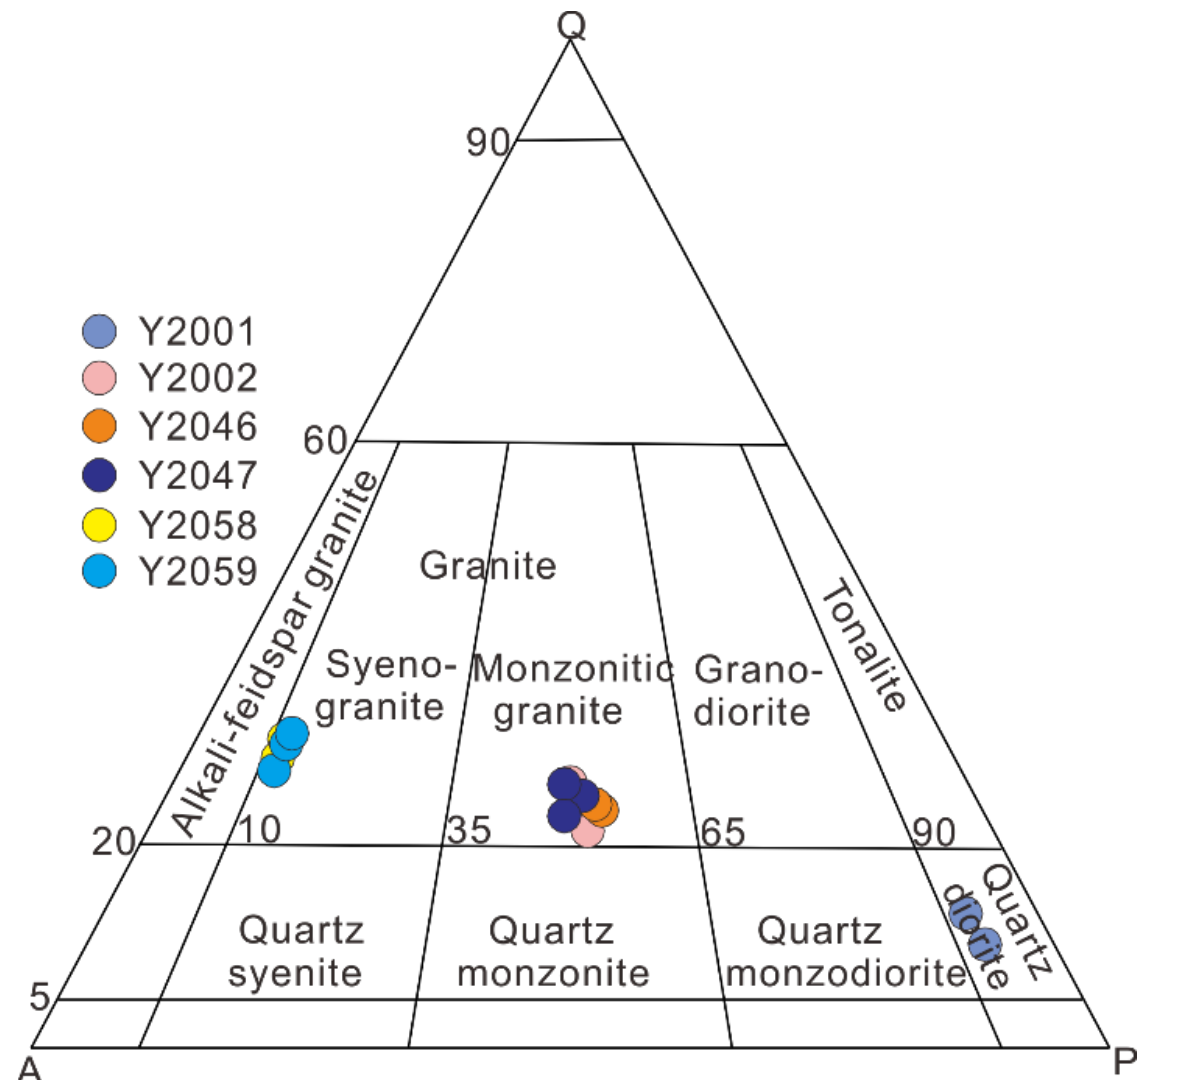
Figure 8. A ternary QAP plot showing the relative modal proportions of quartz (Q), alkali feldspar (A), and plagioclase (P) for the rocks [46,47].